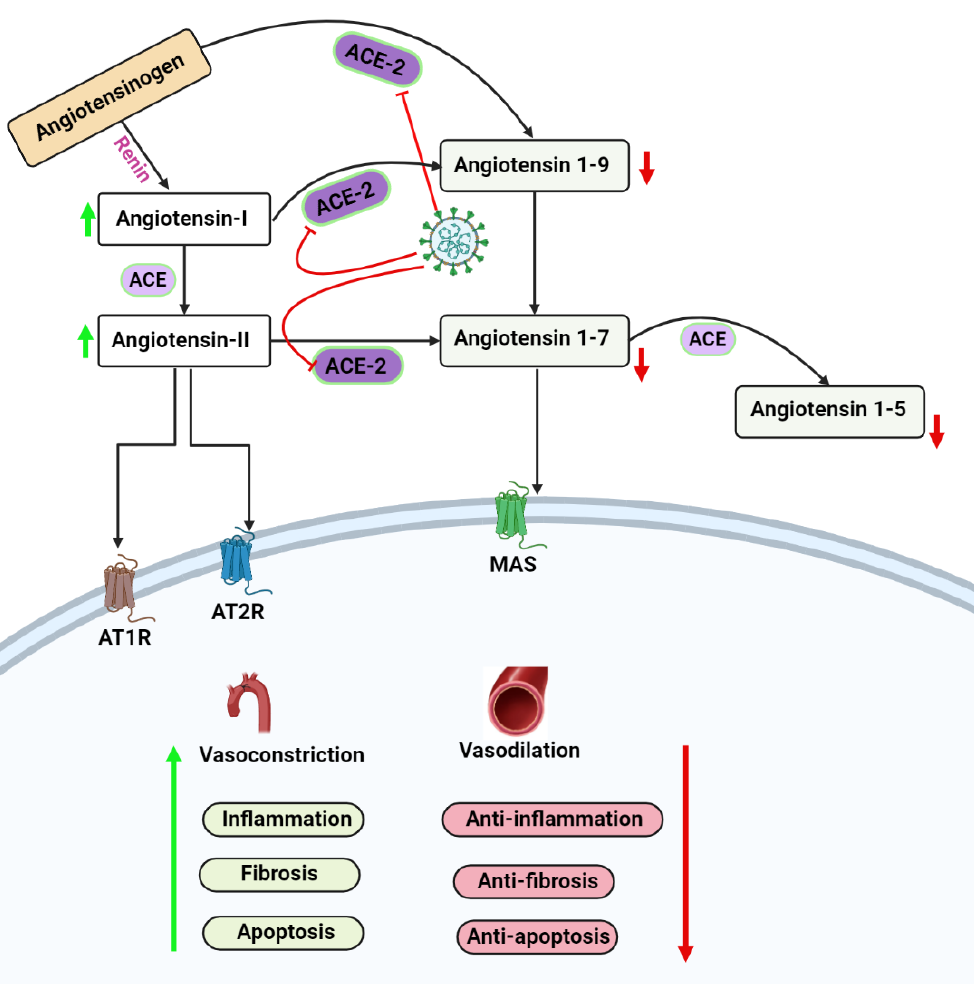
Figure 1. This figure gives an overview of the RAAS system